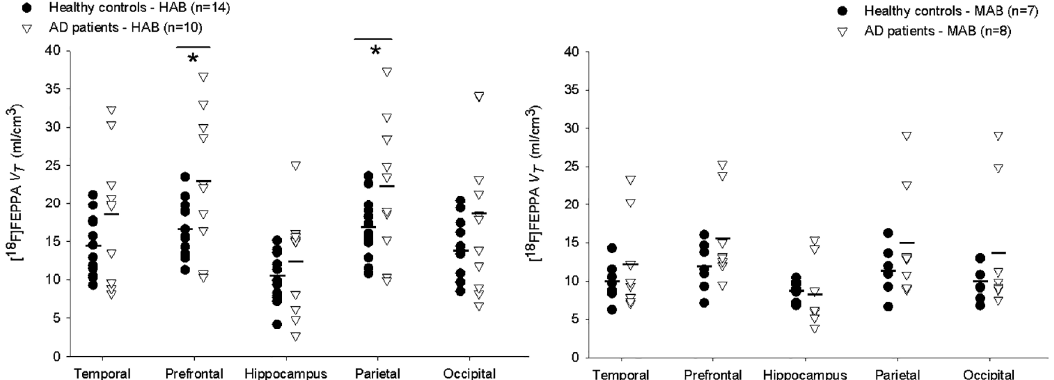
Fig 5. Comparison of [ 18 F]FEPPA regional total distribution volume ( V T ) between healthy control subjects and AD patients calculated with PBIF75 for HABs (left) and MABs (right). ( cf . figure 1 in ref [7]). PBIF75 estimationled to the same conclusionas the previously publishedwith ASIF: [ 18 F]FEPPA V T in AD patients is on average13–48%higherthan HC (A Factorial ANOVA with genotypeand age as covariateshowed: p < 0.05in the Temporal, Prefrontal, Parietal and Occipital and p = 0.4 in the hippocampus). Images were partial volume effect corrected prior to TAC extraction. * p < 0.05 in ANOVA within